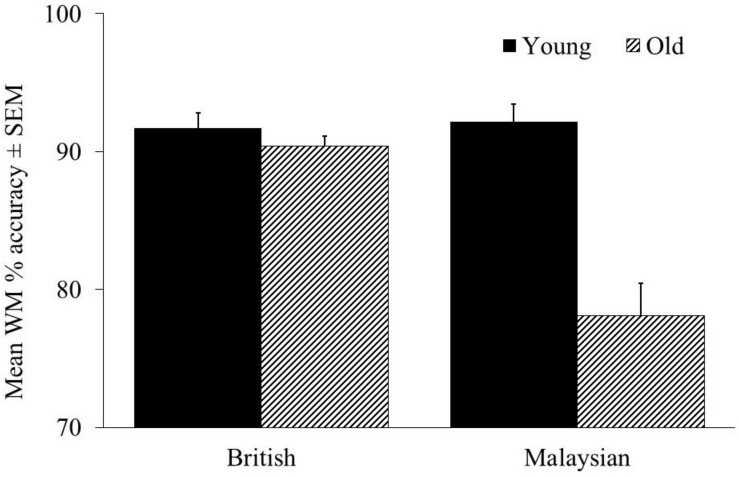
WM accuracy for the British and Malaysian participants. WM, working memory; E, education; C, culture is coded as 1 = British and 2 = Malaysian. *p < 0.05, **p < 0.01, and ***p < 0.001.